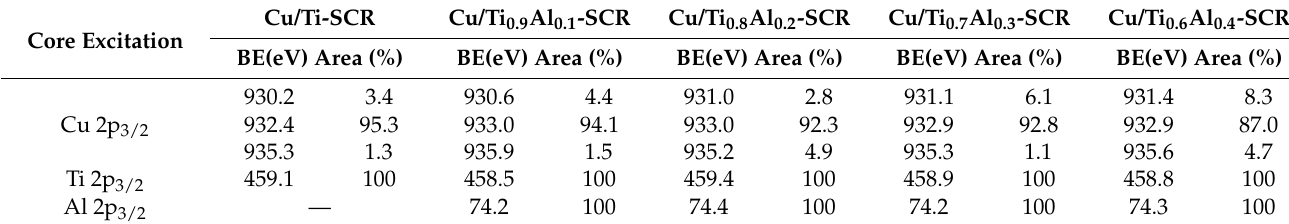
Table 4. XPS data of used catalysts.